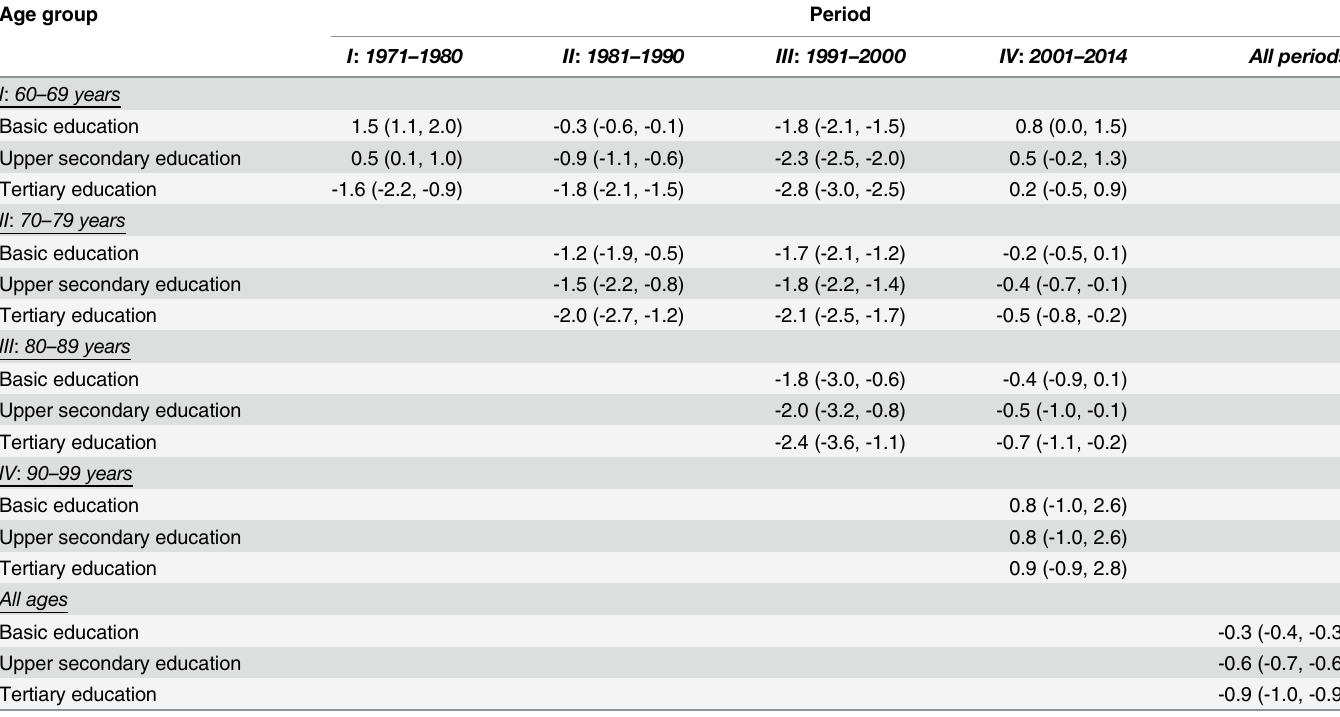
Table 4. Average annual change in hospital admissions, in per cent (95% CI), estimated from clog-log models by age group and period, men.